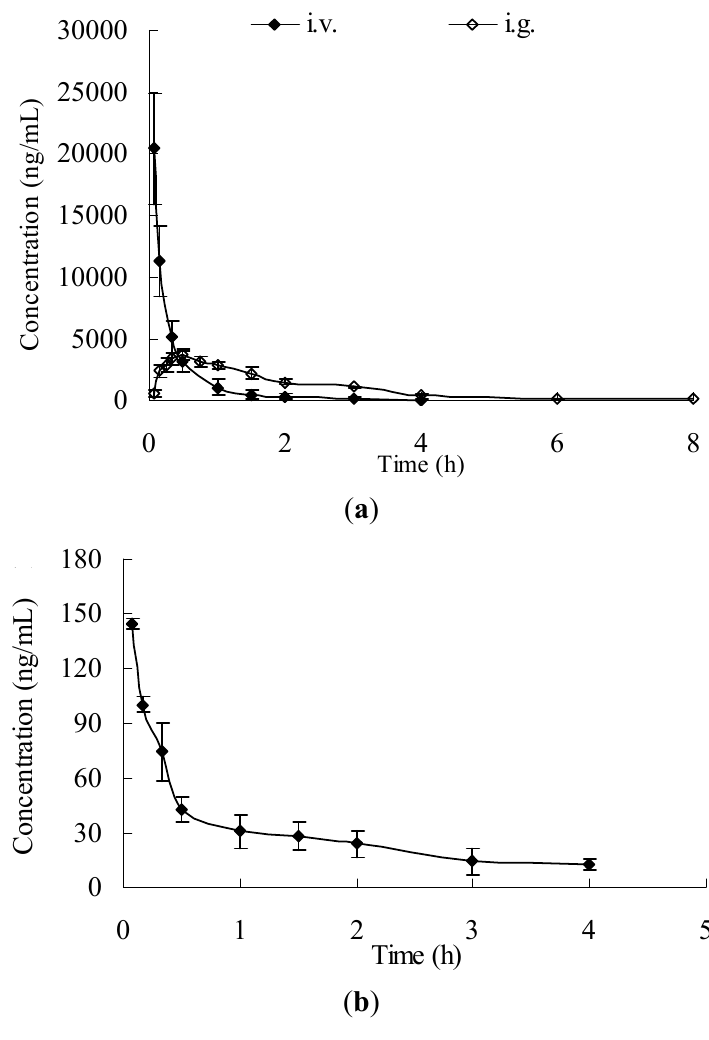
Table 6. Pharmacokinetic parameters of salidroside and p- tyrosol in rats (n = 6).